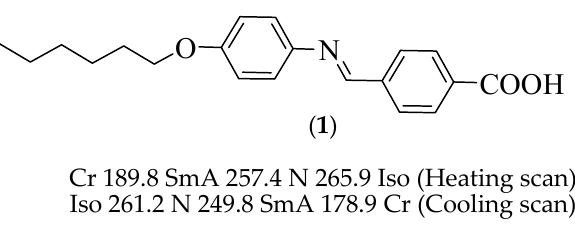
Figure 1. Differential scanning calorimetry ( DSC) thermograms of supramolecular acid 1 upon heating and cooling scans with heating rate 10